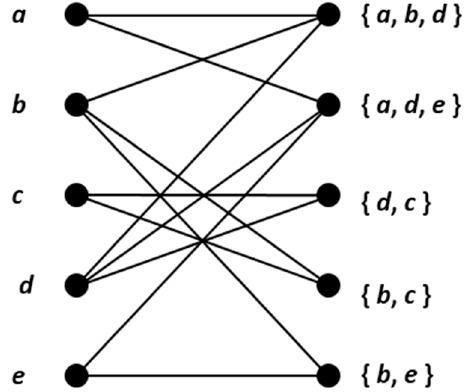
Figure 8. An example of graph compression. The k -partite set intersection graph of Figure 6 has been reduced to a bipartite set intersection graph.